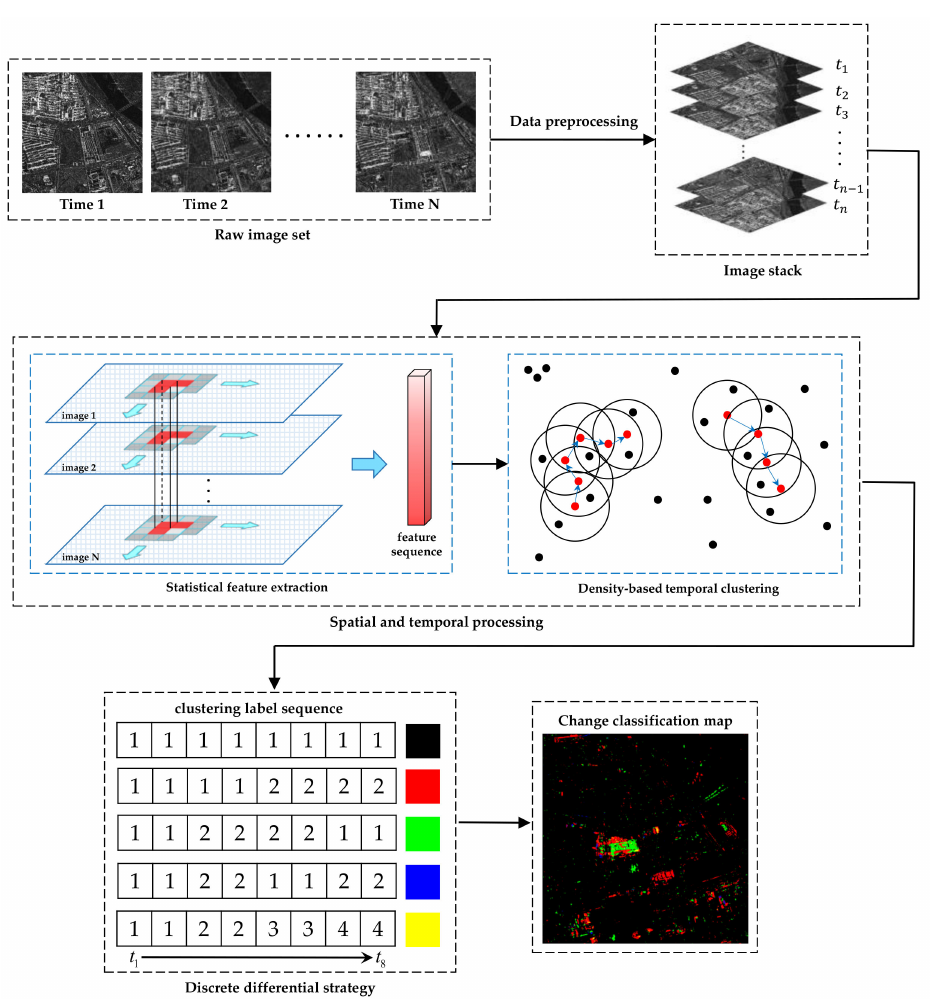
Figure 1. The workflow of the proposed time-series change detection